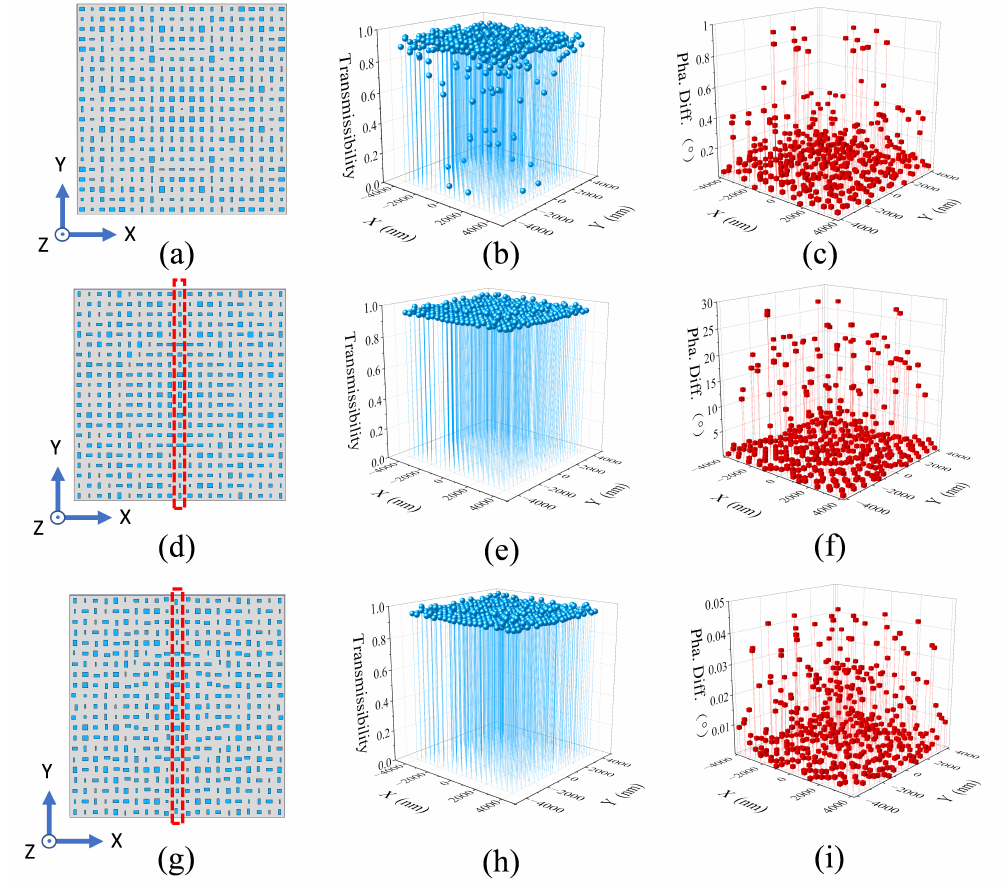
Figure 2. (Color online) Comparison between the typical and threshold-improved metalenses. ( a – c ) The top view, nanopillar transmittance, and phase difference of the typical metalens. ( d – f ) Cor- responding figures of the threshold-improved metalens. ( g ) Top view of the optimized metalens. ( h ) The nanopillar transmittance. ( i ) The phase